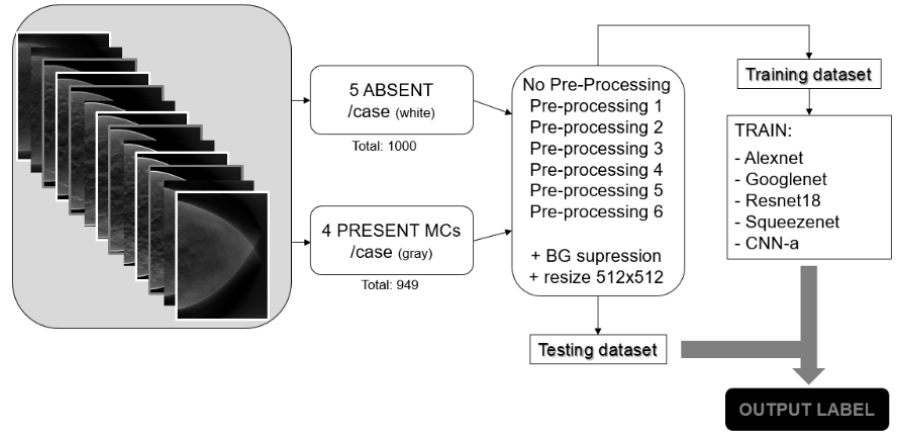
Figure 3. Summary of the methodological pipeline followed in this work.